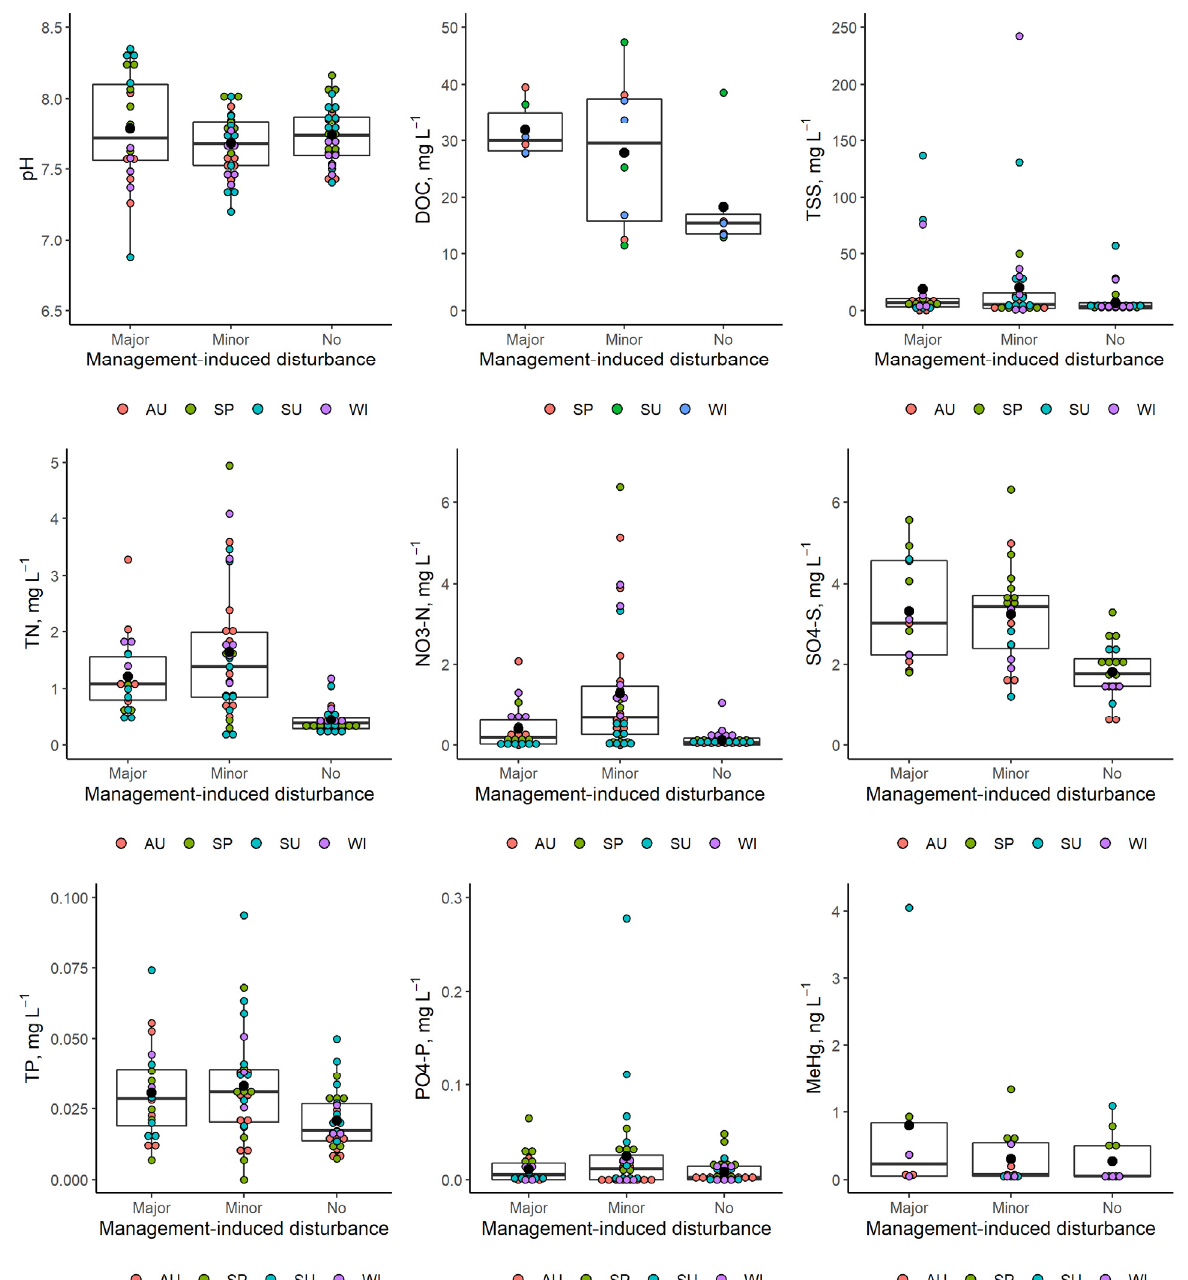
Figure 2. Variation of water general chemistry (pH and concentrations of DOC (dissolved organic carbon), TSS (total suspended solids), TN (total nitrogen), NO 3 − -N, SO 42 − -S, TP (total phosphorus) and PO 43 − -P) and MeHg concentration in small watercourses of drainage systems in forest land with organic soils by groups of management-induced disturbance. In the boxplots, the median is shown by the bold line, the mean is shown by the black dot, the box corresponds to the lower and upper quartiles, whiskers show the minimal and maximal values (within 150% of the interquartile range from the median) and dots outside the box and whiskers represent outliers of the datasets. Coloured dots represent different